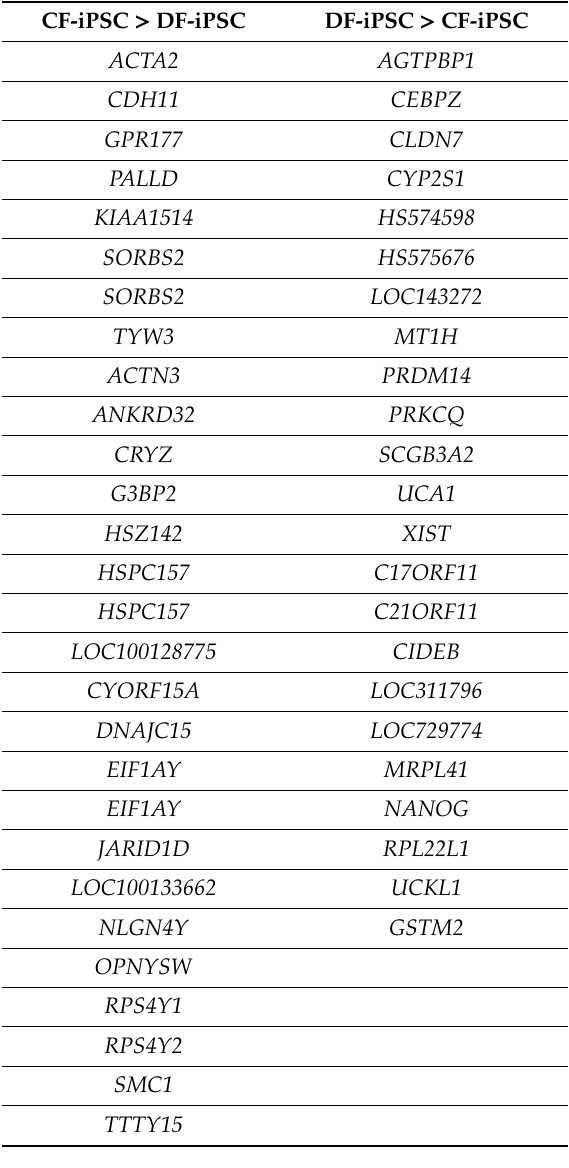
Table 1. Contrast analysis—genes that were